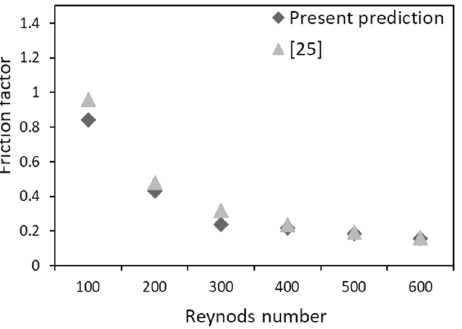
Fig. 7 Comparison of relative Nusselt number versus Reyn- olds number in the channel with simple baffle and different BRs (BR = h/H = 0.2, 0.4, and 0.6, θ =